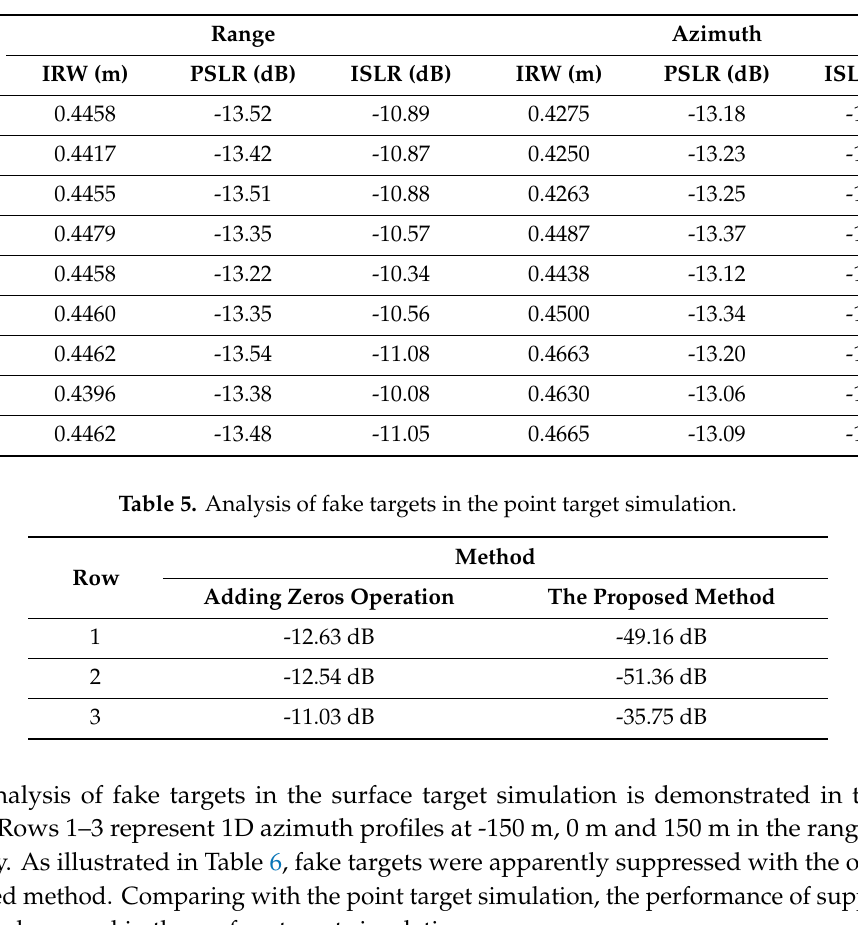
Table 4. Analysis of point target simulation with the proposed method.